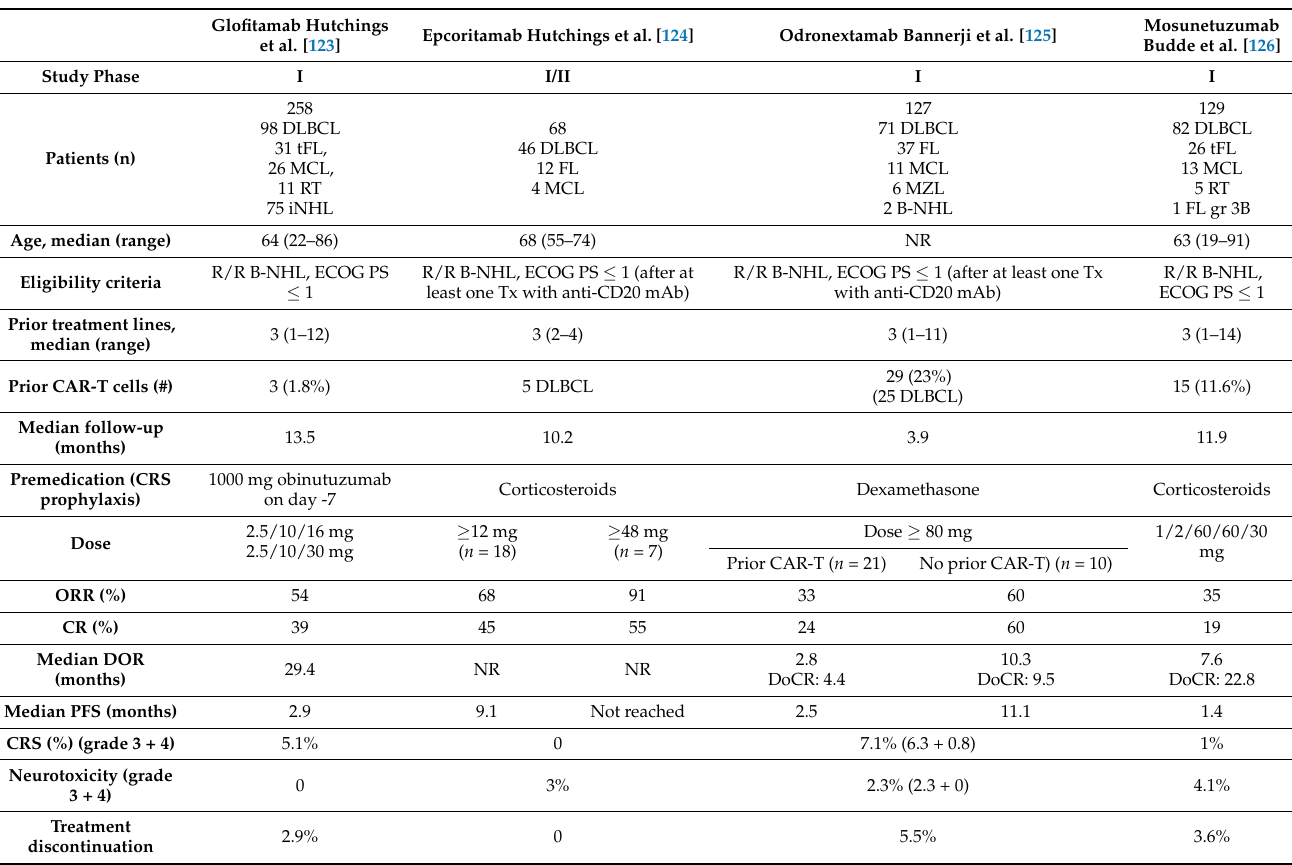
Table 8. Characteristics of studies evaluating CD3xCD20 bispecific antibodies in the treatment of R/R